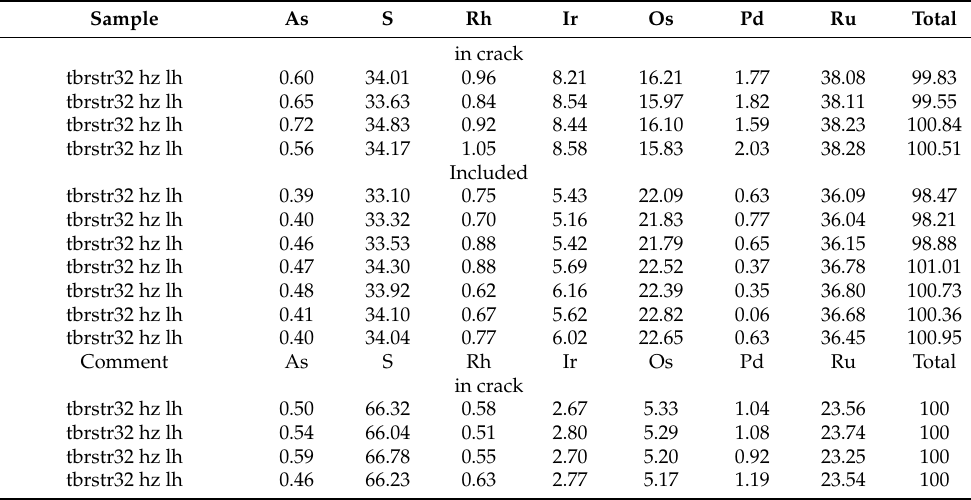
Figure 12. Plots (atom %) of the compositions of laurite from the chromitites of Kabaena (present work) and Sulawesi [38].